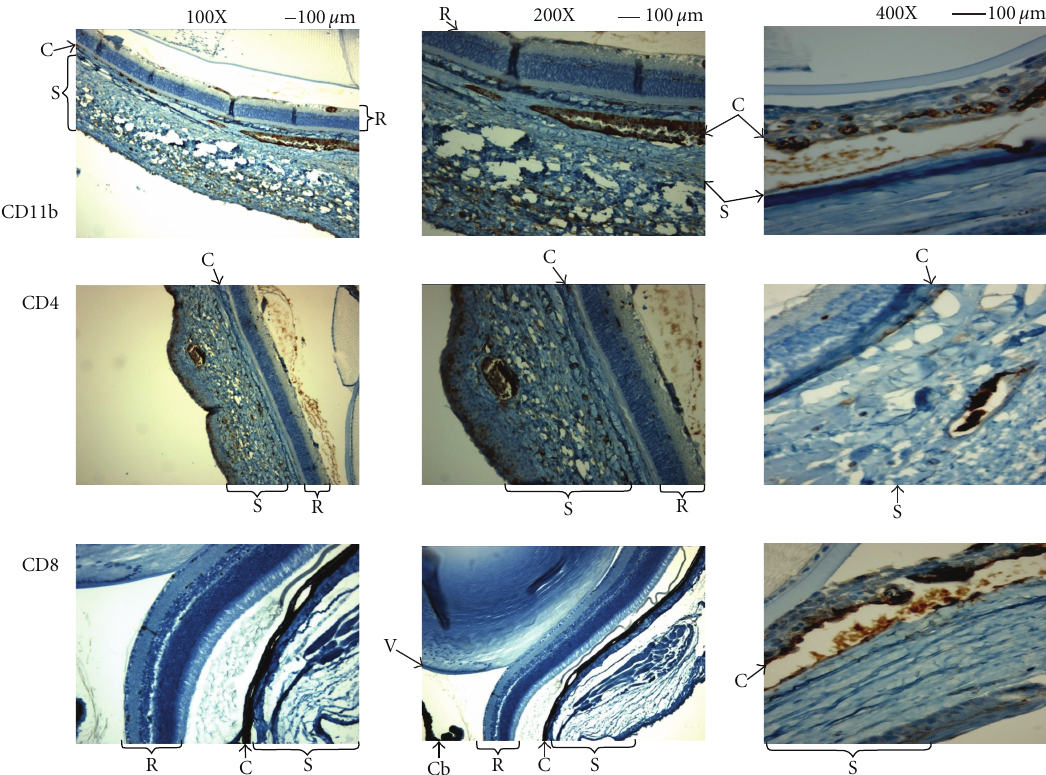
Figure 3: Representative immunohistochemistry of eye tissues showing that treatment with resolvin D1 (100ng/kg, 1 h post-LPS) reduces inflammation and immunostaining for CD11b and CD4 and CD8. Magnification was 100x, 200x, and 400x. C = choroid; Cb = ciliary body; R = retina; S = sclera; V =